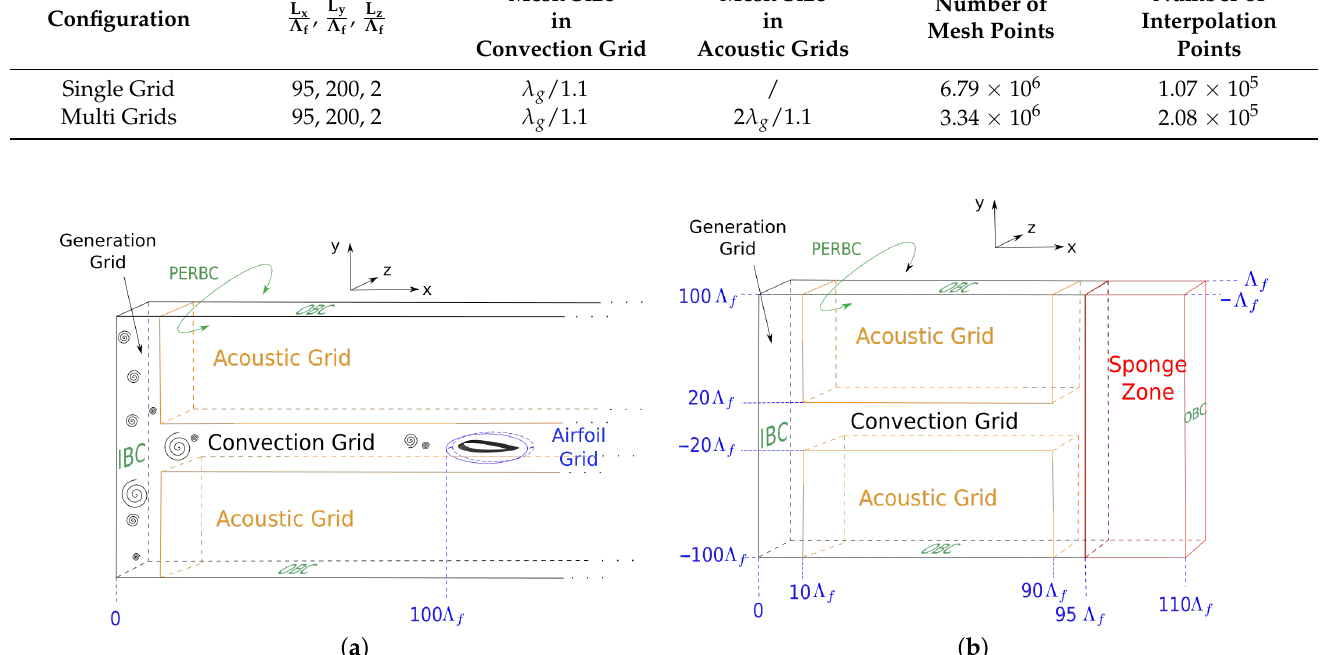
Table 1. Geometrical and mesh data for both Single Grid and Multi Grids configurations. Λ f stands for the longitudinal integral length scale and λ g for the transverse Taylor micro-scale of the turbulence. Configuration